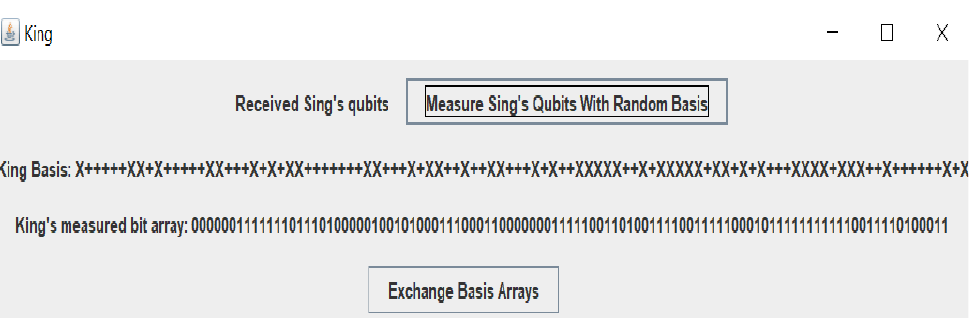
Figure 3. Singh collecting RI, producing a base, SOP, and sharing multi-qubit list to King.